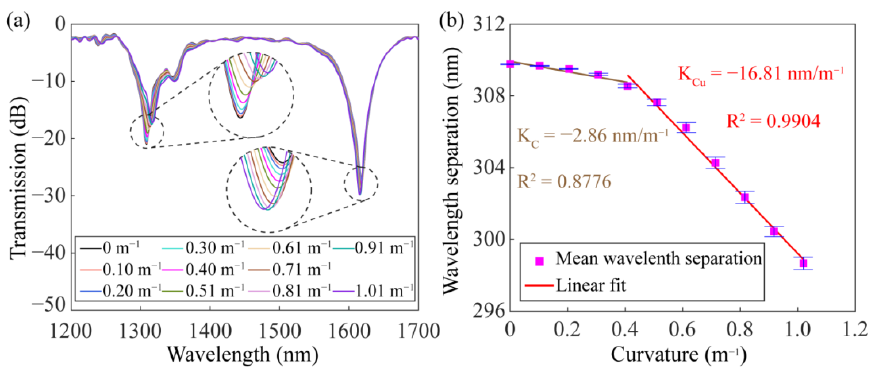
Figure 16. ( a ) Transmission spectra of the dual-resonance SMF-HLPG with different curvatures. ( b ) The dependence of mean wavelength separation on the curvature.